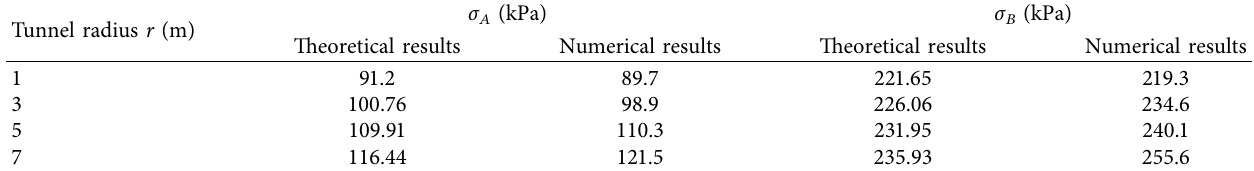
Table 2: Comparison between theoretical and numerical simulation results. Tunnel radius r